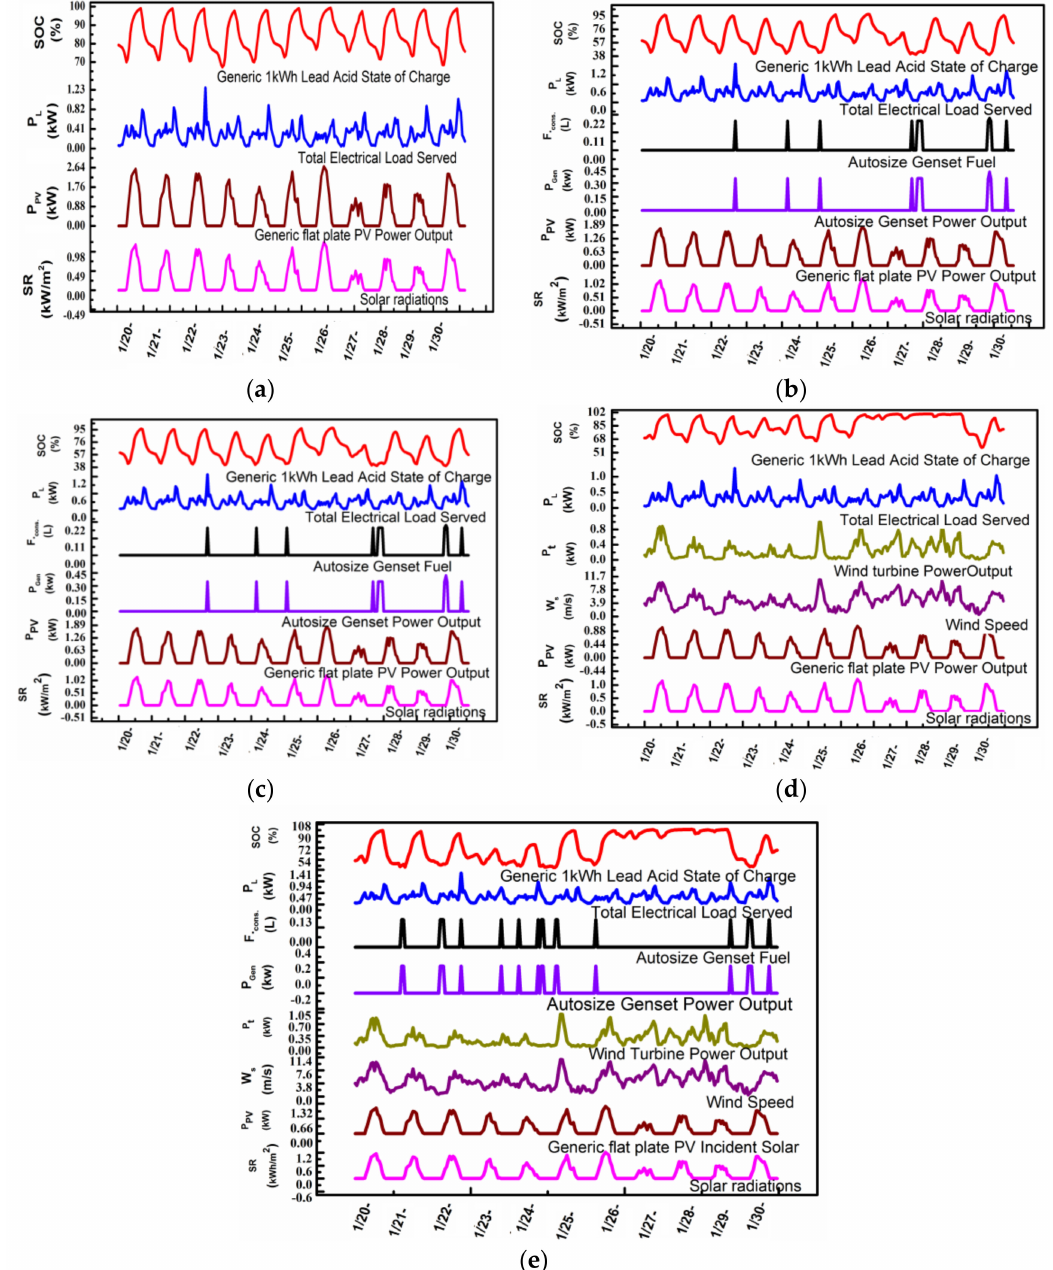
Figure 11. State of charge of lead-acid batteries, available solar radiation, wind speed, total load served output power by wind and solar panels, power delivered by auto size-DG and Fuel consumption ( a ) SPV; ( b ) SPV-GEN; ( c ) W-GEN; ( d ) SPV-W; and ( e )